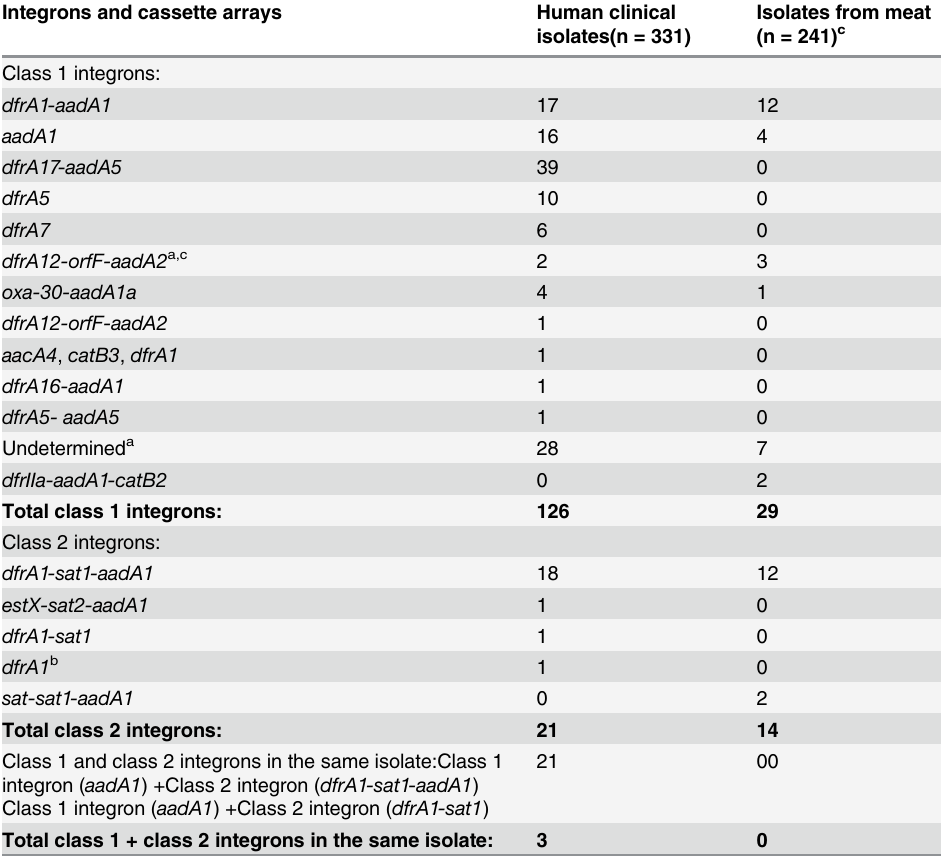
Table 2. Number of integrons and different cassette arrays occurring in antimicrobial resistant Escherichia coli originating from humans with blood stream infections and in antimicrobial resistant E . coli originating from meat and meat